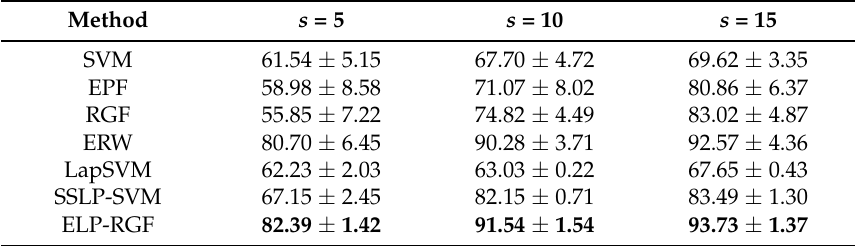
Figure 9. Classification maps of different methods for the Indian Pines image. ( a ) Reference image, ( b ) SVM method; ( c ) EPF method; ( d ) RGF method; ( e ) ERW method; ( f ) LapSVM method; ( g ) SSLP-SVM method and ( h ) ELP-RGF method. Table 2. Overall accuracy of the various methods for the University of Pavia image (average of 10 runs with thestandard deviation; the bold values indicate the greatest accuracy among the methods in each